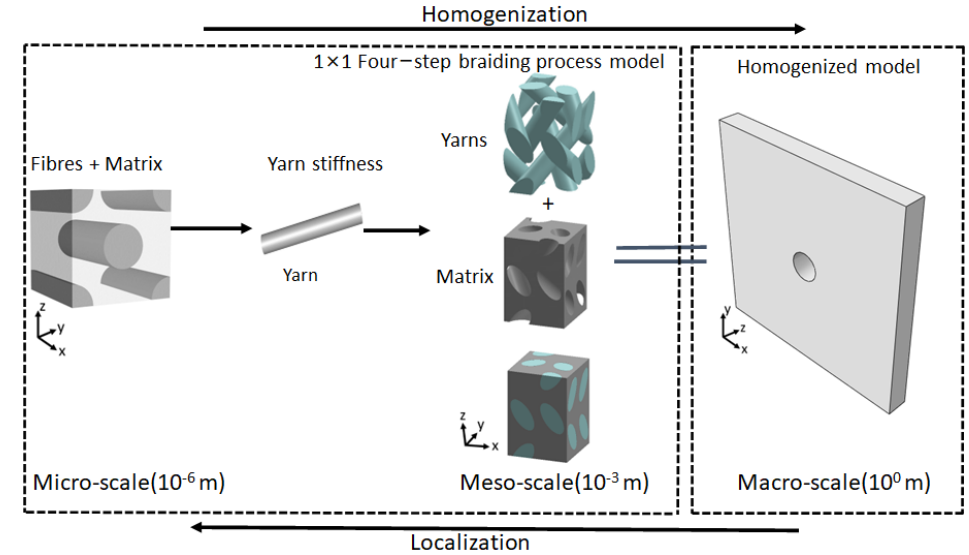
Figure 1. Multiscale modeling for braided polymer plate.